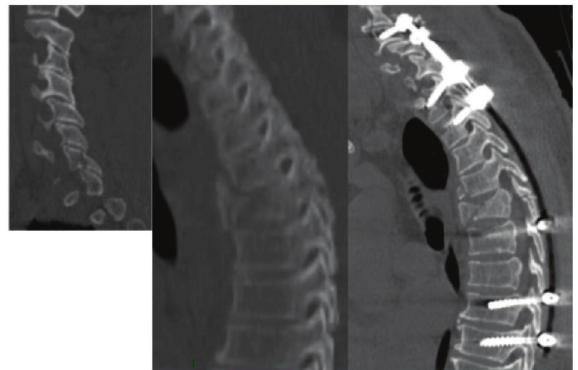
Figure 5: A 71-year-old man with traumatic fracture of the lower cervical spine and the T4-T5 vertebral bodies. A long fixation was carried out with hybrid procedure utilizing a double diameter